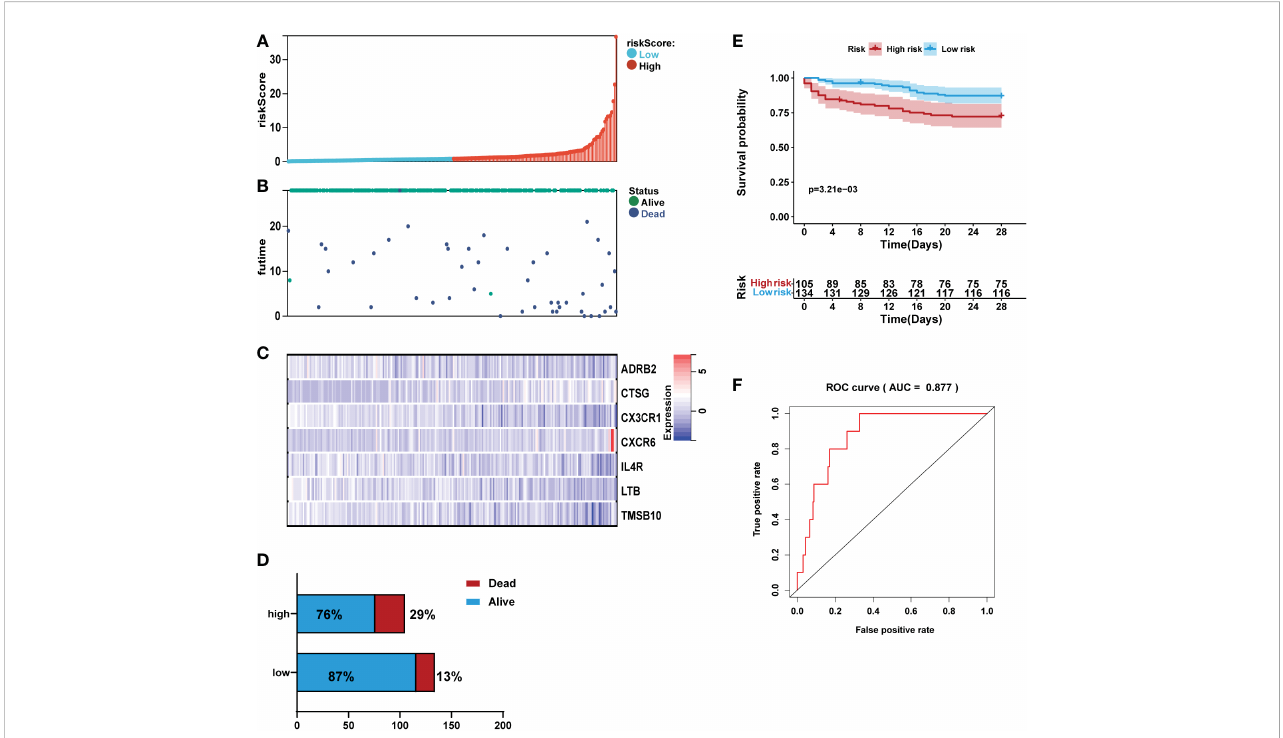
FIGURE 6 Validation of the prediction performance of the prognostic signature in the validation set (n=239). (A) Bar plot of a risk score for every patient and ordered by the value of risk score. (B) Distribution of vital survival status and risk scores of the immune signature. (C) Heatmap of the mRNA expression levels of the seven signature-comprising immune genes. (D) Comparison of survival risk between two groups. (E) Kaplan-Meier survival analysis of the gene signature in the validation set. (F) ROC curves of the seven-mRNA signature in sepsis.